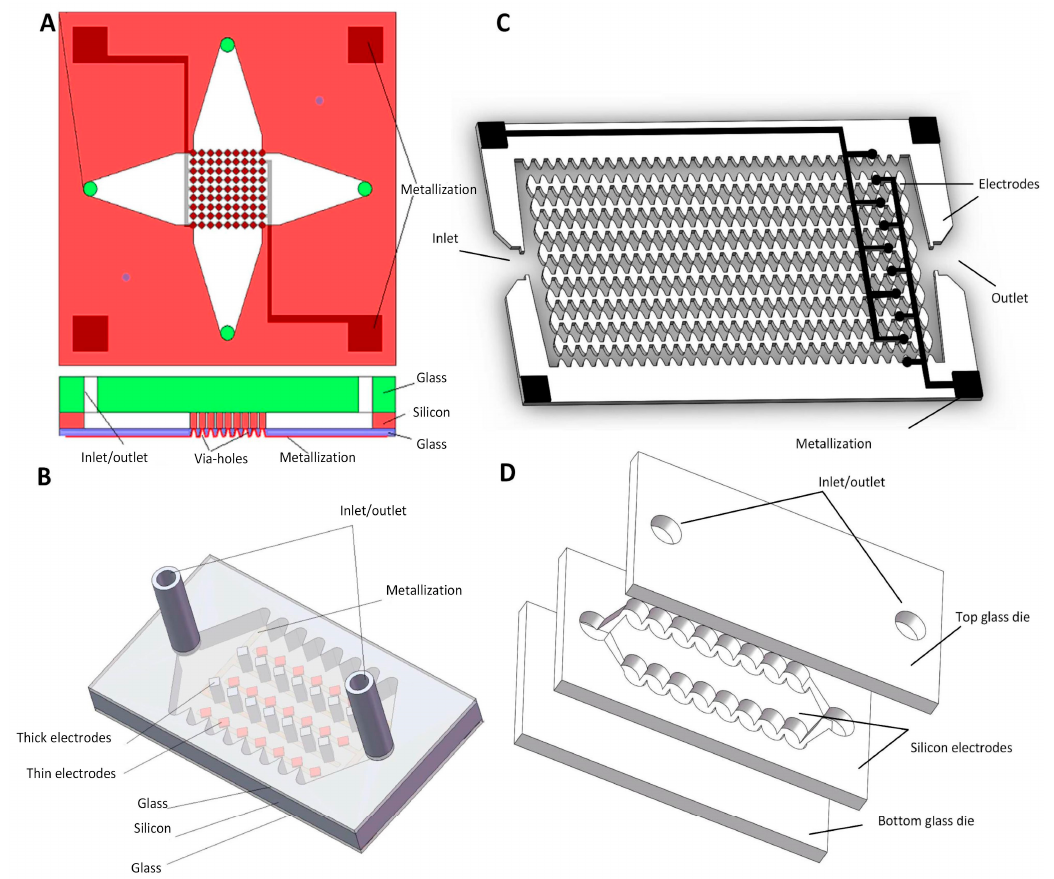
Figure 15. Microfluidic devices with silicon 3D electrodes. ( A ) Schematic of the device with silicon electrode pillars of a uniform height. Reproduced with permission from [82], © 2008 Elsevier. ( B ) Schematic of the device with silicon electrode pillars of a non-uniform height. Reproduced with permission from [83], © 2009 AIP Publishing. ( C ) Schematic of the device with symmetrical silicon electrodes [84]. ( D ) Schematic of the device with bulk silicon electrode [85].